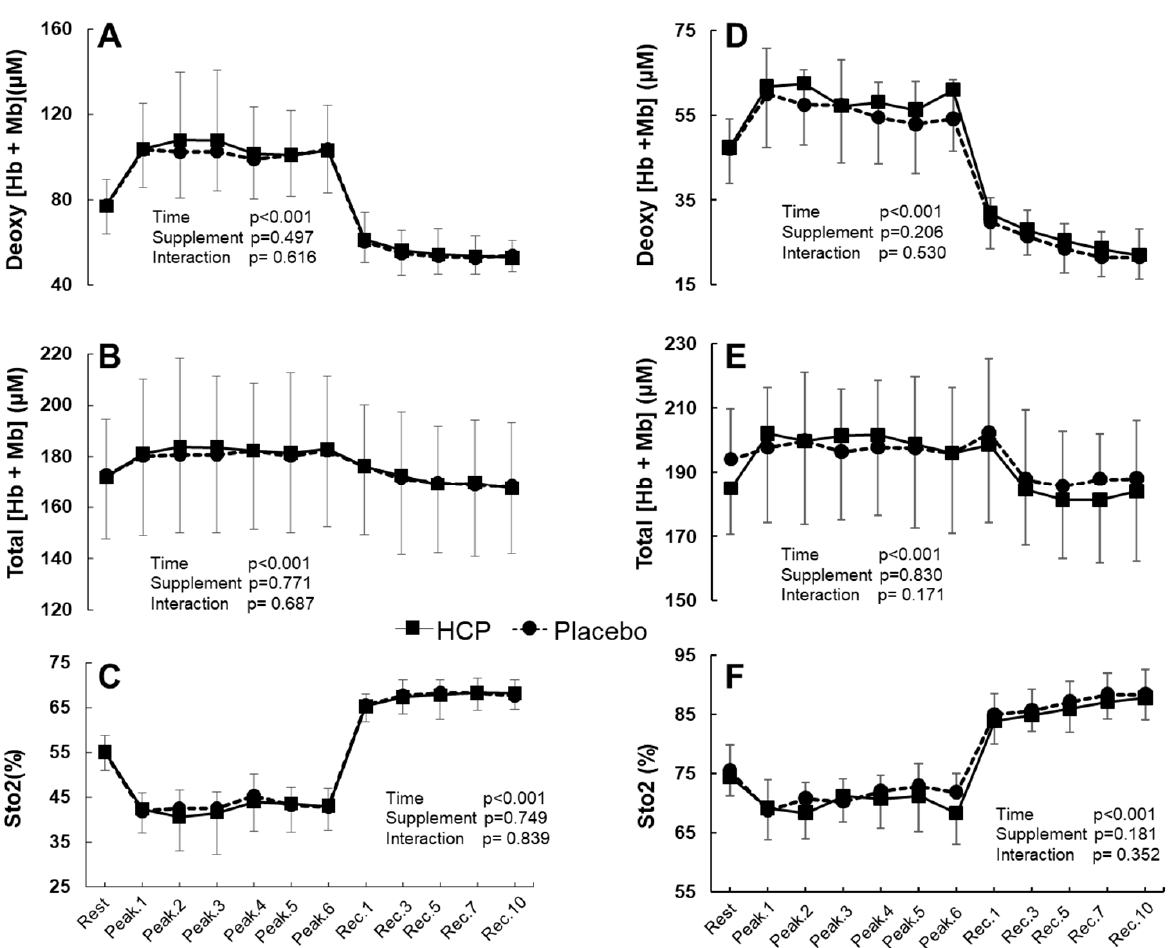
Figure 3. Group mean values for the rectus femoris ( RF ) muscle deoxygenated hemoglobin and myoglobin concentration (deoxy[Hb + Mb]) ( A ), the total hemoglobin and myoglobin concentration (total[Hb + Mb]) ( B ), and tissue O 2 saturation (S t O 2 ) ( C ). The vastus lateralis ( VL ) muscle deoxy[Hb + Mb] ( D ), total[Hb + Mb] ( E ), and S t O 2 ( F ) at rest, peak values during the 7 s all-out bout for each set (Peak.1~6), and the recovery period (Rec.1~10) in the HCP and placebo groups. Error bars: SD. Overall values in the RF and VL muscles showed no significant difference between the groups. Table 2 presents the mean peak values of TR-NIRS profiles in the RF and VL muscles between HCP and placebo across the six peaks (mean peak.1~6) of the HIIT exercise. In the RF , the mean peak deoxy[Hb + Mb] and S t O 2 values showed no significant difference between the groups. However, the total[Hb + Mb] was significantly higher with HCP than placebo (HCP: 183 ± 1 vs. Placebo: 181 ± 1 µ M, t (5) = 2.973, p = 0.031, d = 1.214). In the VL muscle, the mean peak values of deoxy[Hb + Mb] displayed a significant difference of approx. 4 µ M in deoxy[Hb + Mb] with HCP compared to placebo (HCP: 60 ± 3 µ M vs. Placebo: 56 ± 3 µ M, t (5) = 3.438, p = 0.018, d = 1.404), which demonstrated a possibly greater O 2 extraction at peaks during the HIIT exercise in the VL muscle. However, no significant difference was observed in the VL muscle, with similar mean peak values of total[Hb + Mb] and S t O 2 between HCP and placebo